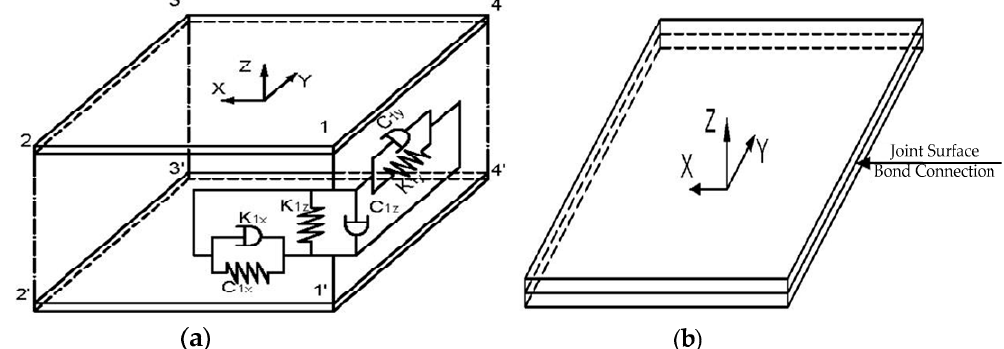
Figure 3. Schematic diagram of three-dimensional model of ( a ) theSDM and ( b ) the FEM.